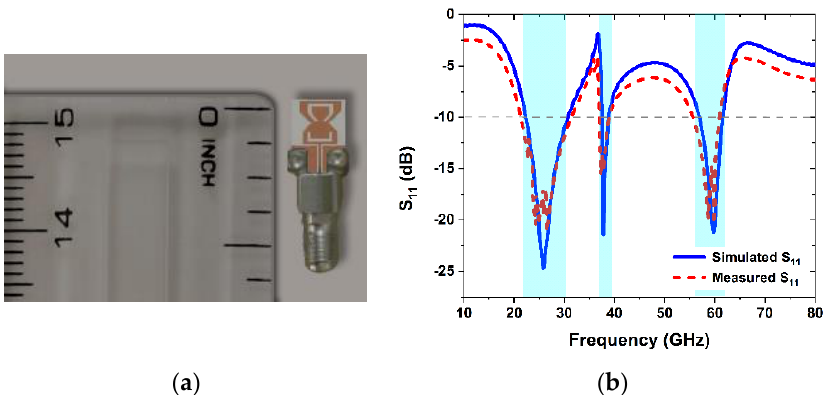
Figure 7. ( a ) The prototype of the proposed antenna; ( b ) comparison between the simulated and measured return